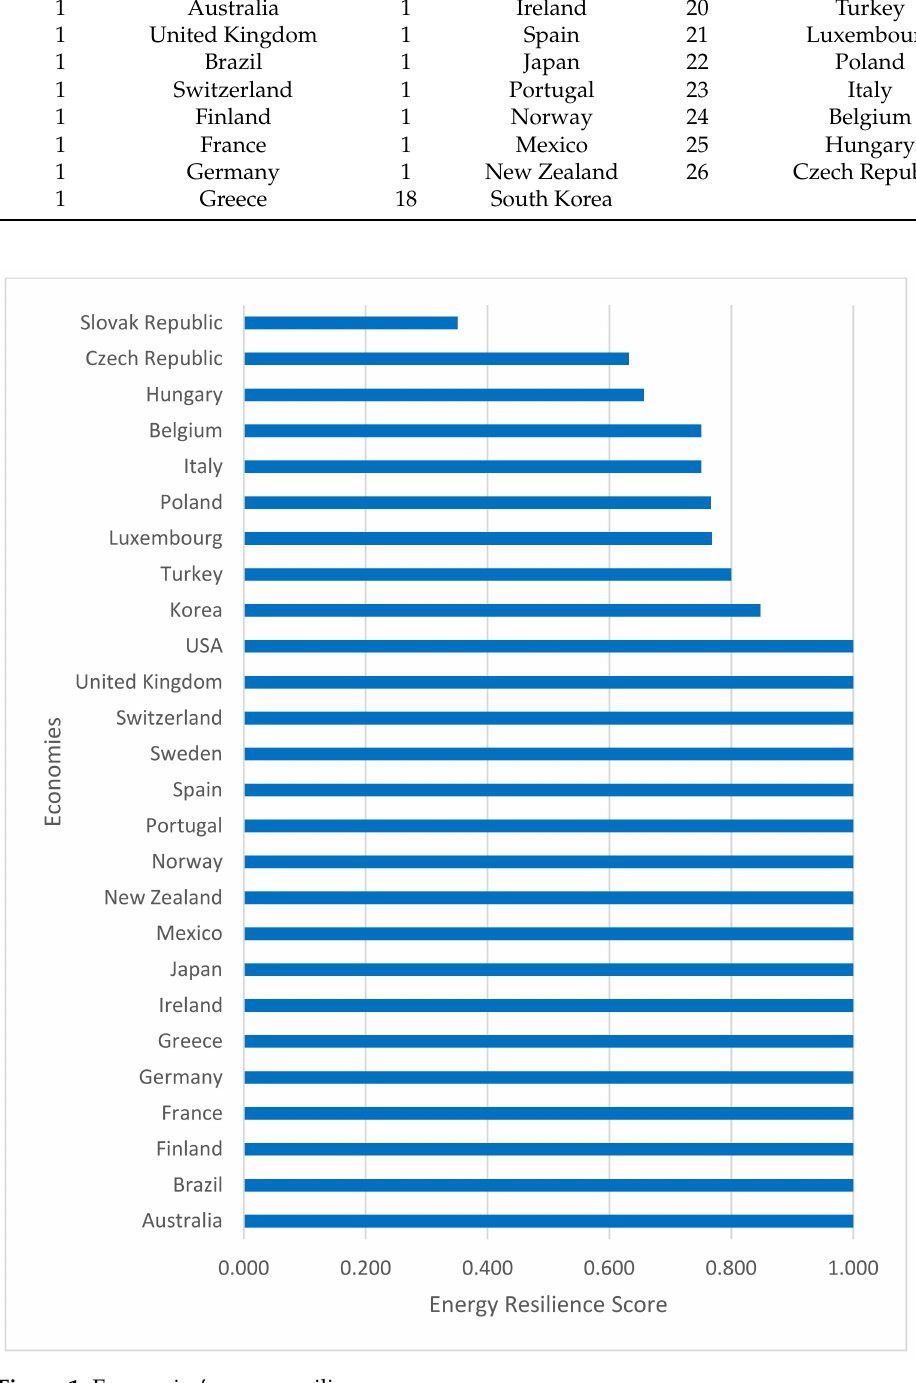
Figure 1. Economies’ energy resiliency